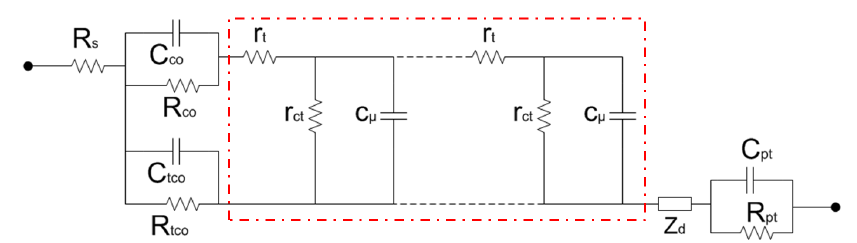
Figure 1. Small signal equivalent circuit of dye-sensitized solar cells (DSCs) used to fit electrochemical impedance spectroscopy (EIS) spectra. The transmission line is outlined by the red box; r t and r ct are discussed in the main text. The model includes also: distributed capacitance of TiO 2 ( c µ ), series resistor ( R s ), charge-transfer resistance ( R TCO ) and double-layer capacitance ( C TCO ) at the exposed transparent conducting oxide (TCO)-electrolyte interface, resistor ( R CO ) and capacitor ( C CO ) at the TCO-TiO 2 interface, Warburg element ( Z d ) for Nernst diffusion of I − in the electrolyte, charge-transfer resistance 3 ( R pt ) and double-layer capacitance ( C pt ) at the platinized